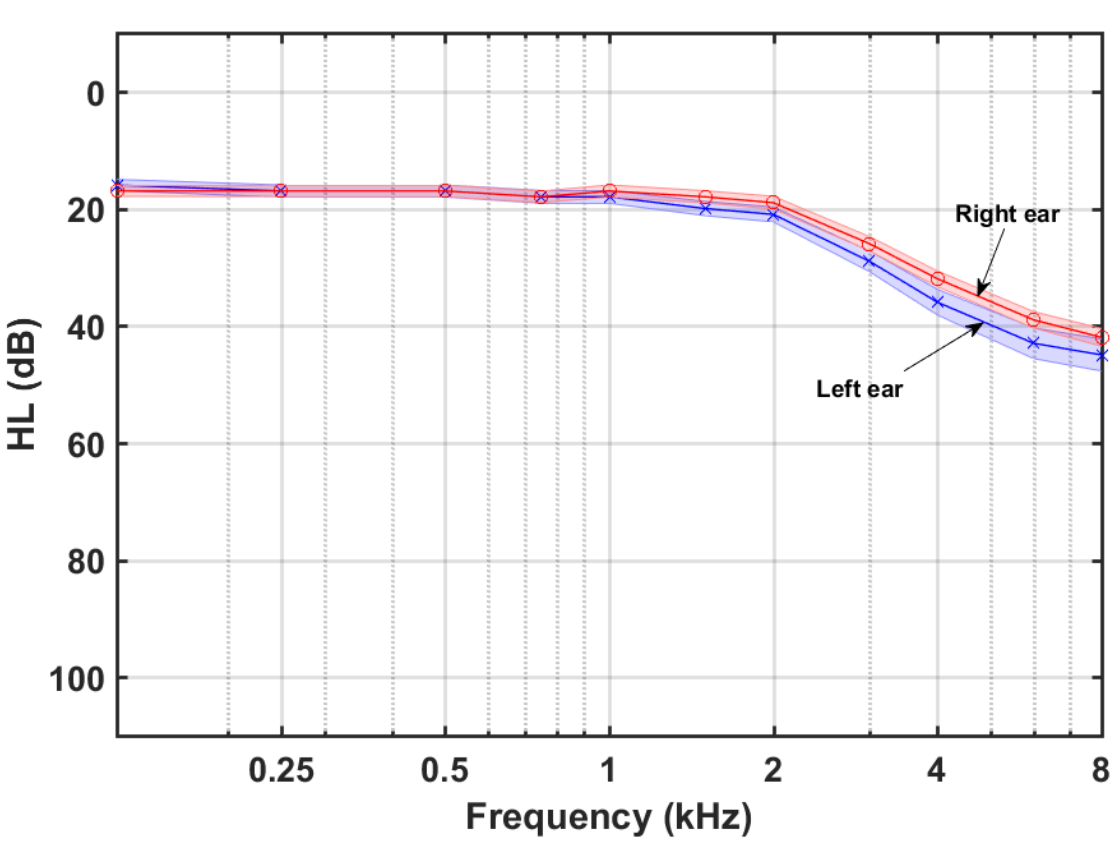
Algorithm 1: Division of different listening participants